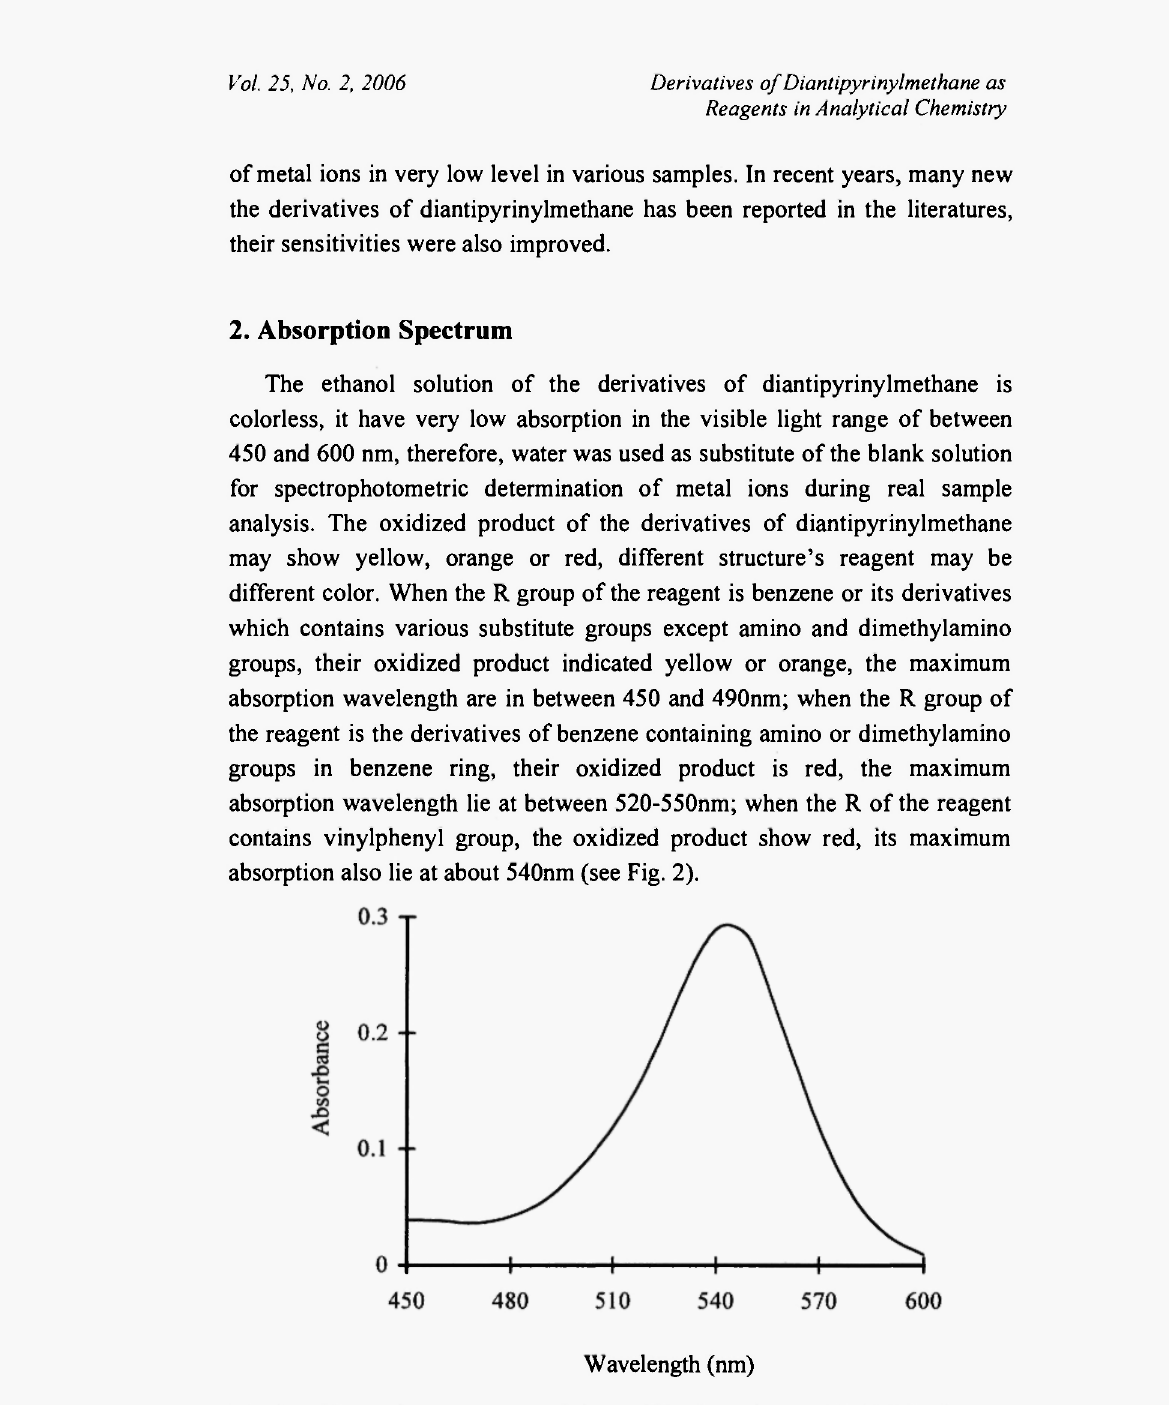
Fig. 2: Absorption spectrum of the oxidized product of DAVM. Cerium (IV),